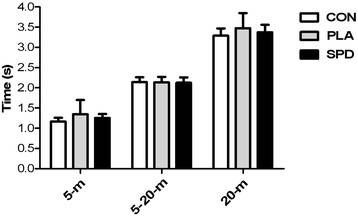
Average (±SD) time spent to cover 5-, 5 to 20- and 20-m sprint values for the 3 conditions (CON, PLA and SPD). Inter-group analysis was carried out using the Kruskal-Wallis one-way analysis; no statistical difference was found.